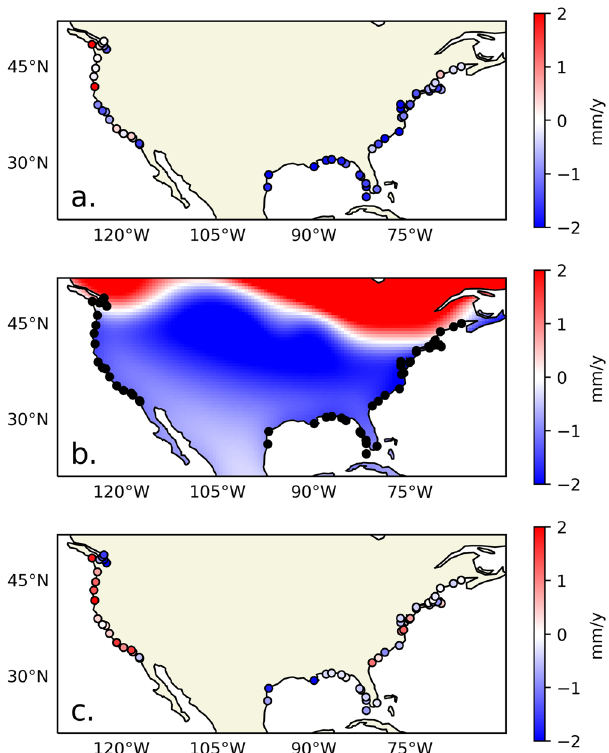
Fig. 3 Vertical land motion trends. Estimates of VLM at each tide-gauge location. a VLM estimated from GPS observations. b VLM associated with GIA. c VLM observed by GPS with the GIA contribution